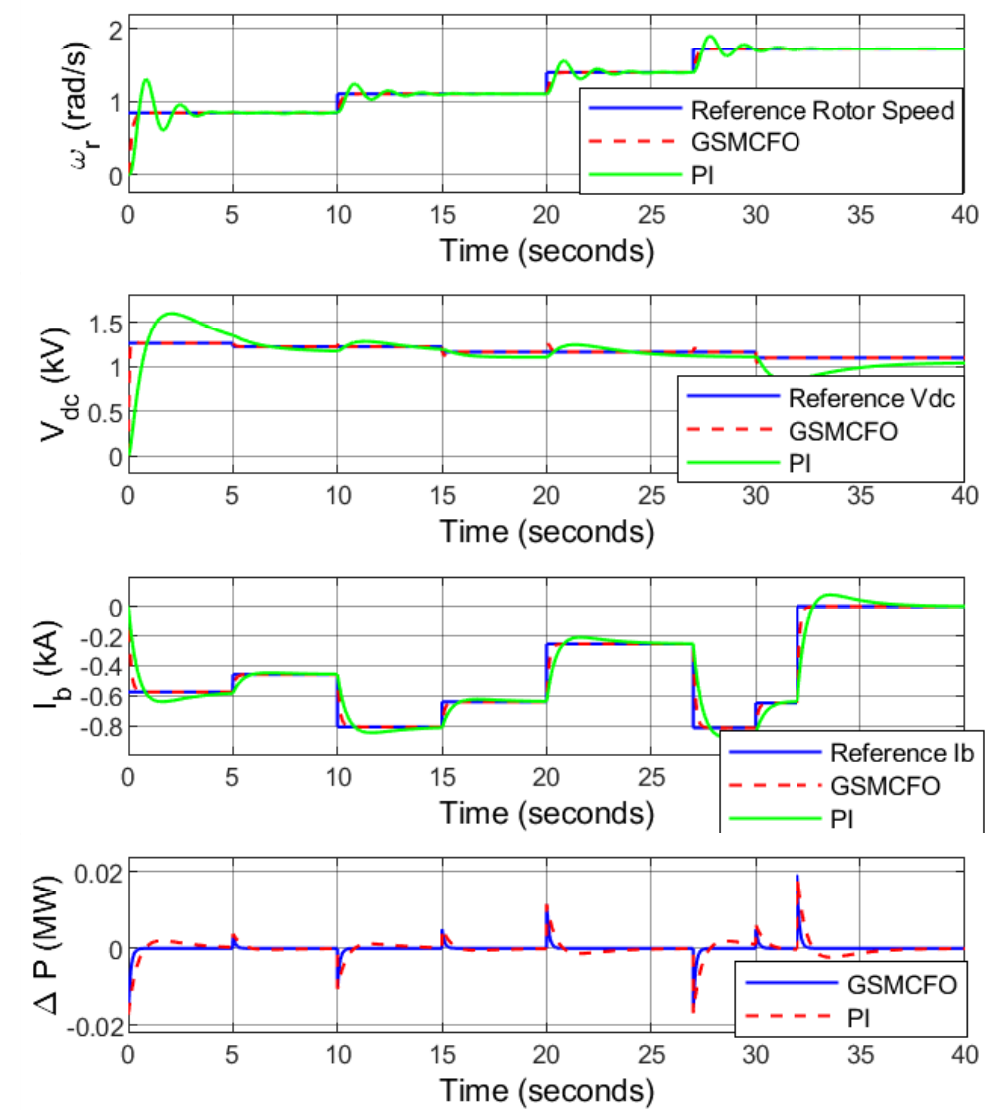
Figure 15. Scenario 4: performance comparison of the proposed GSMCFO with the PI